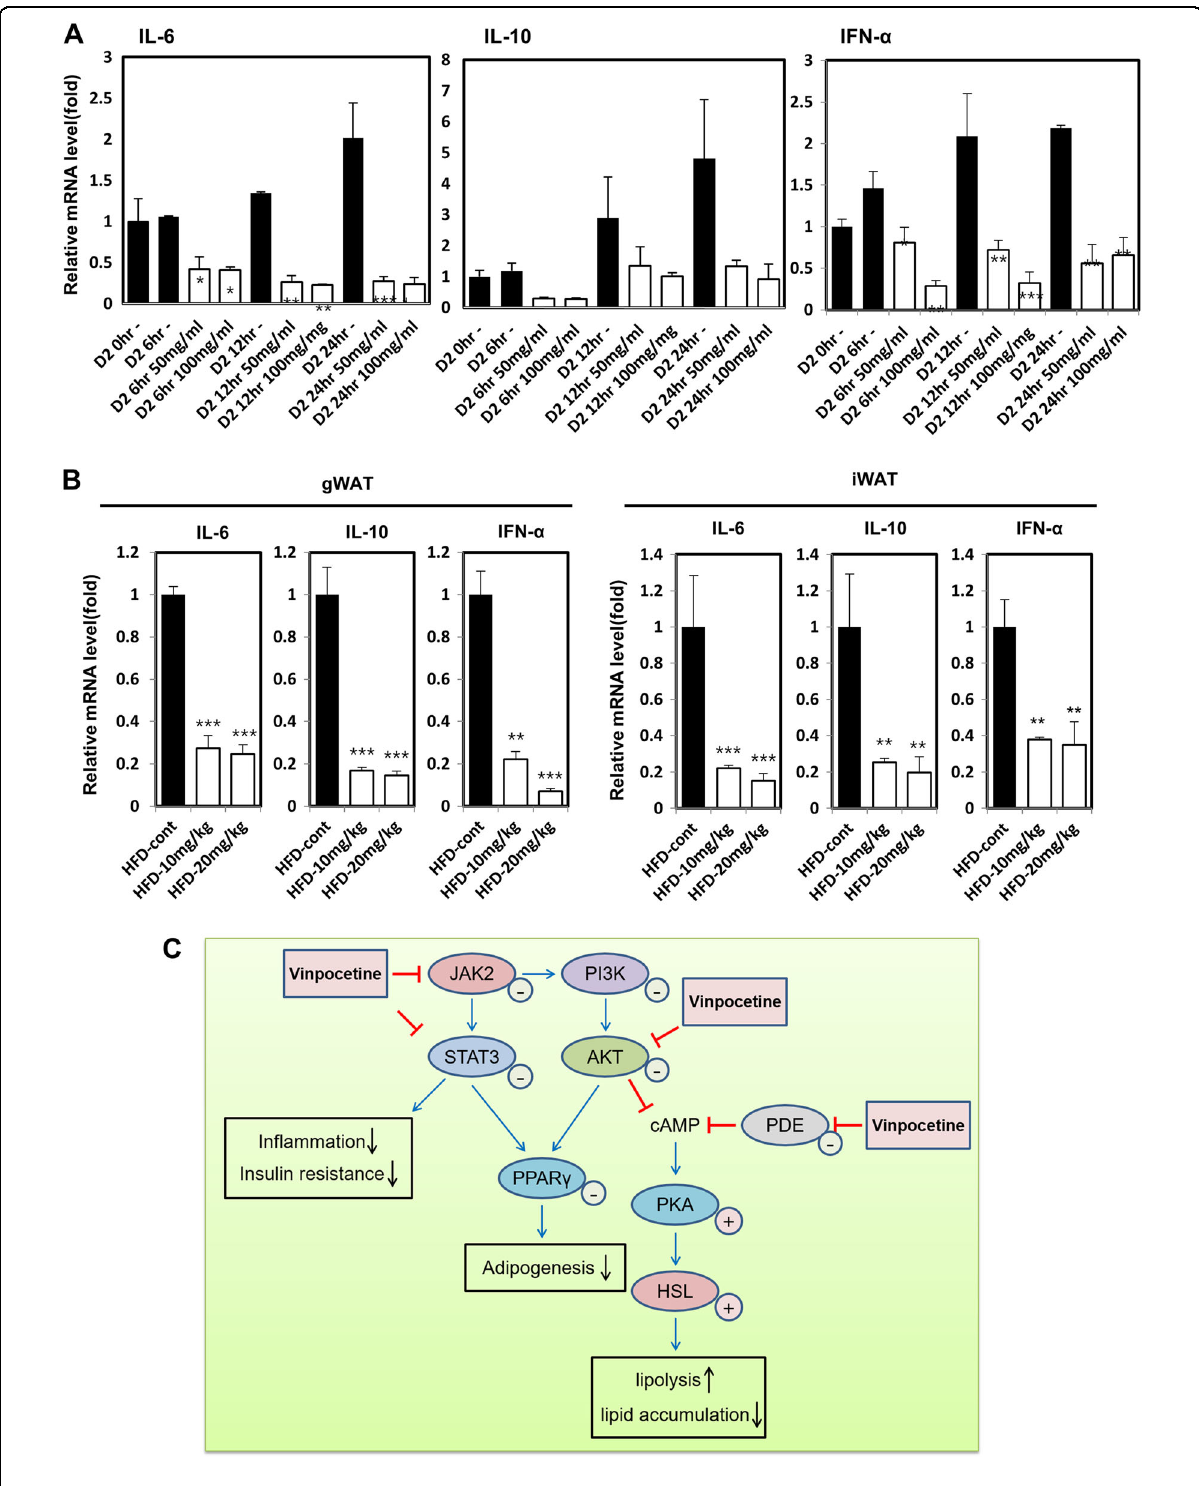
Fig. 6 (See legend on next